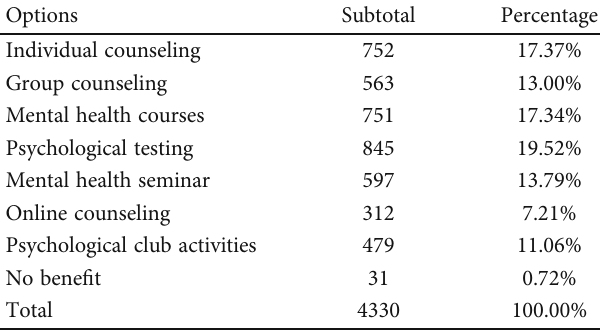
Table 2: Suggestions for improving the management of mental health